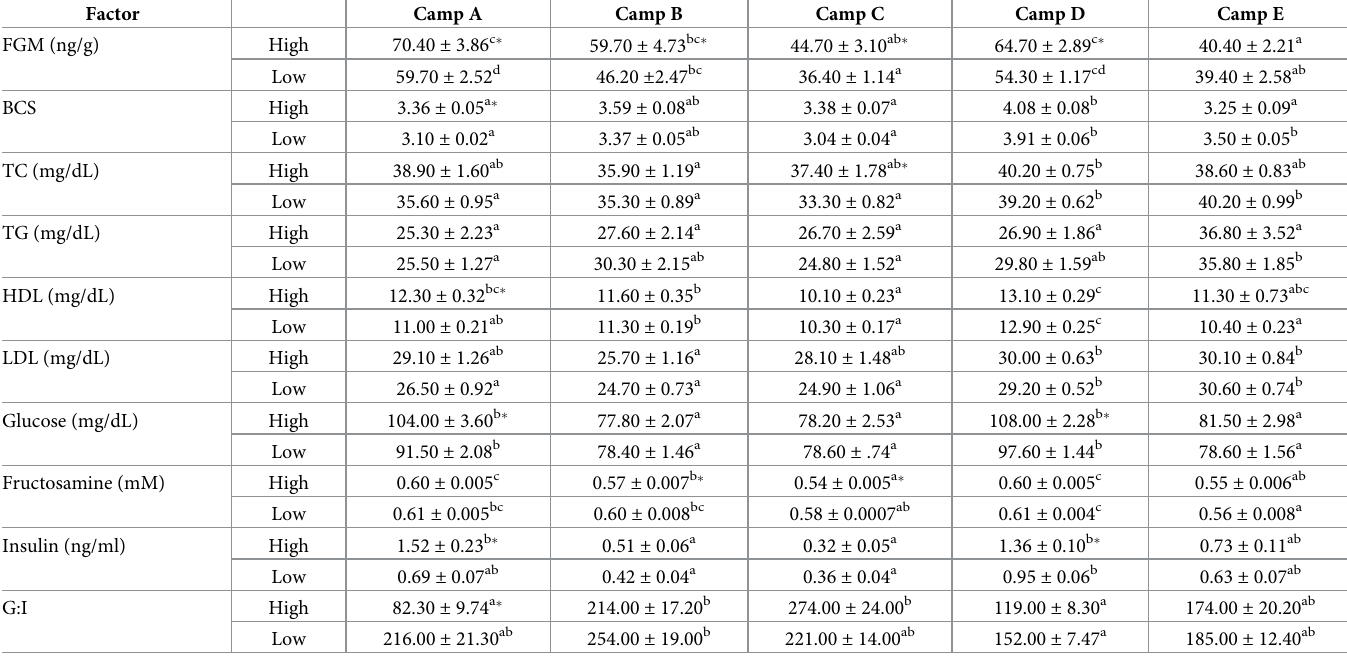
Table 4. Differences in FGM, metabolic and lipid measures in captive elephants managed at five tourist camps. Fecal samples were collected for glucocorticoid analy- ses, and visual body condition scores were determined based on a set of photographs. The elephants were housed at five elephant camps in Northern Thailand, and studied to determine if differences in management (e.g., work activities, feeding, work type) affected physiological function. Factor